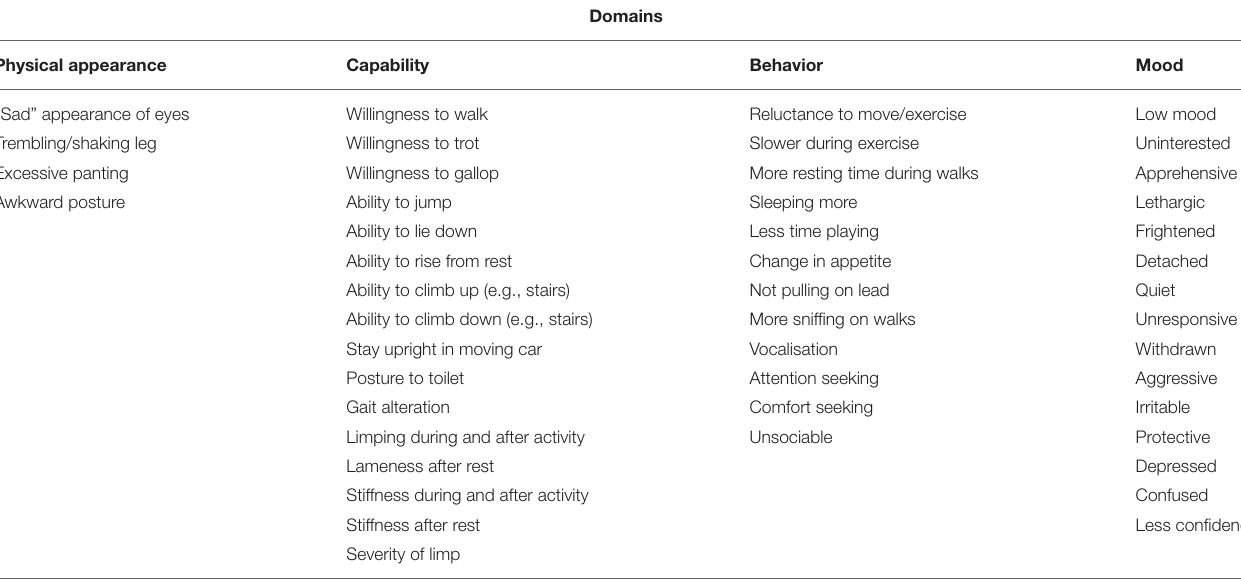
TABLE 1 | Domains and items resulting from a literature review on indicators of HRQOL in dogs with osteoarthritis, after categorization by an expert